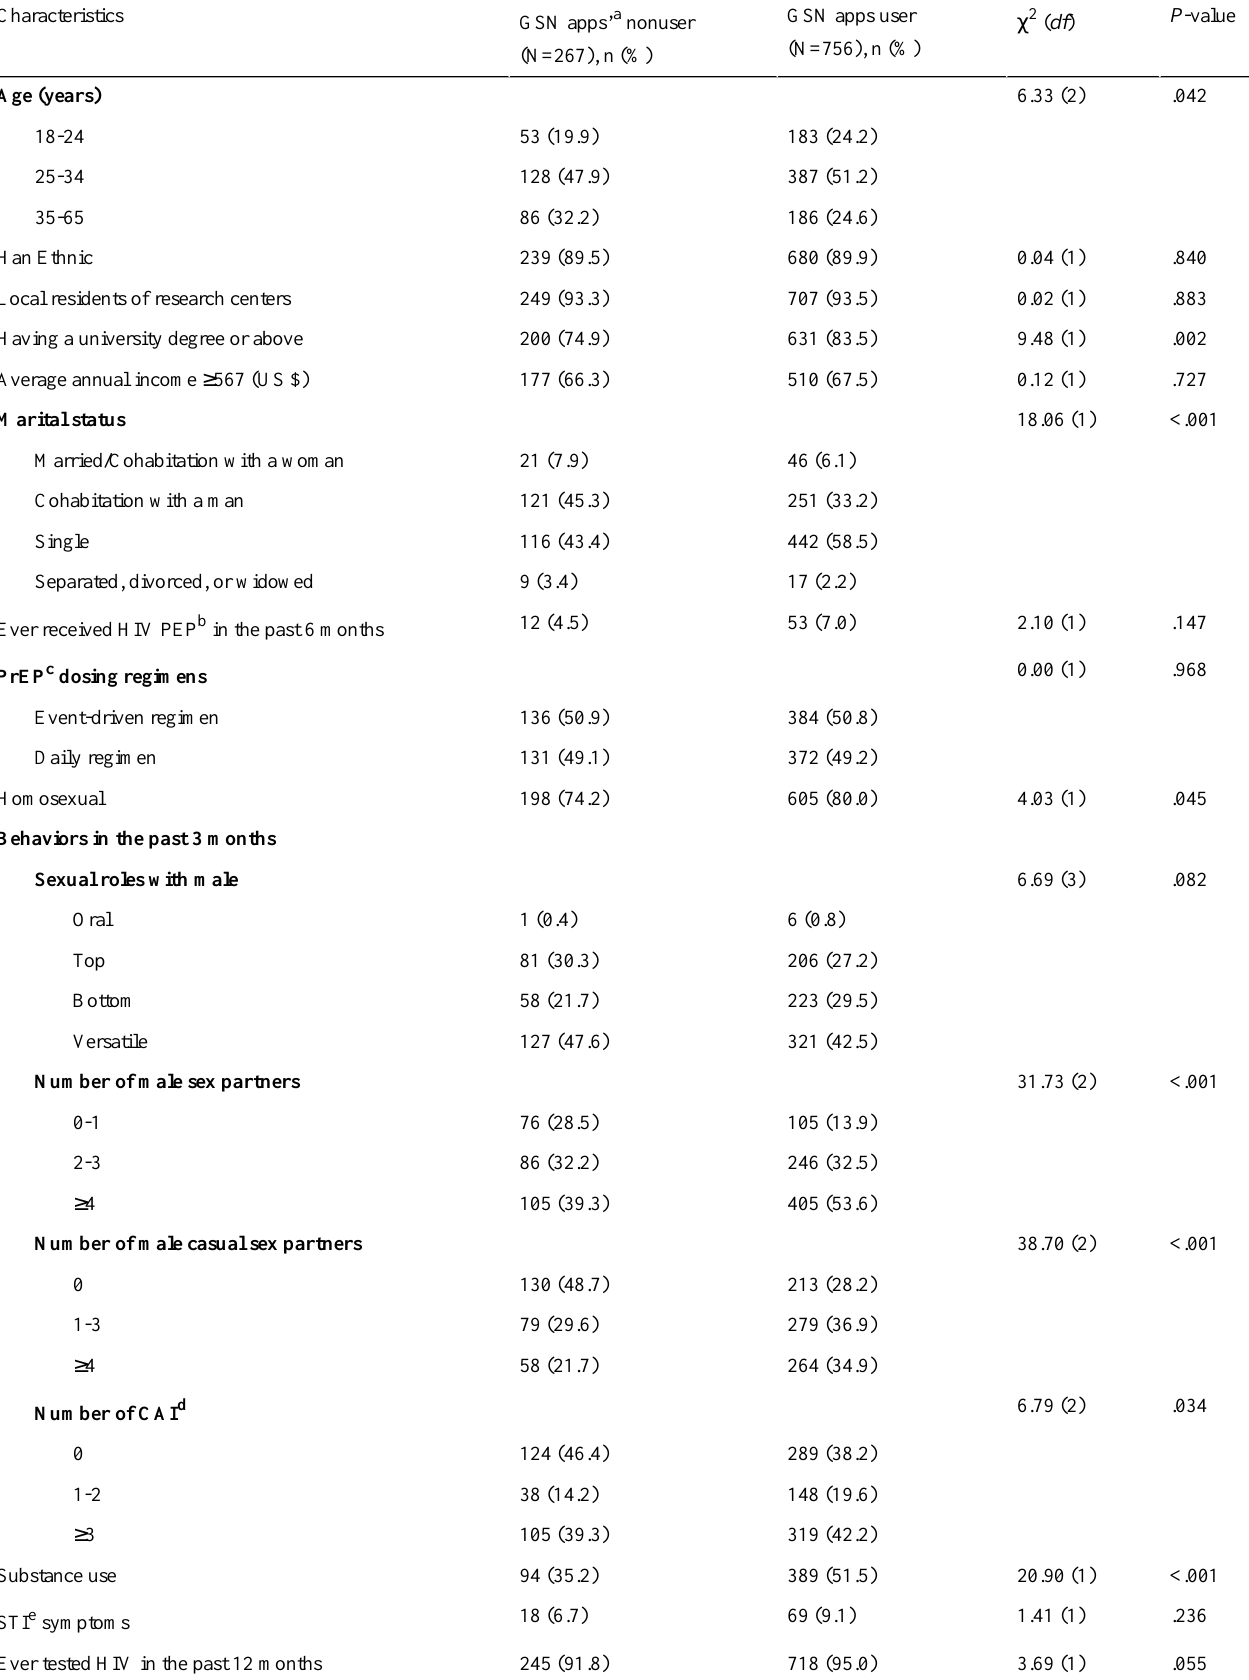
Table 1. Baseline characteristics of MSM on PrEP who did and did not report mainly seeking partners through geosocial networking apps during the past 3 months